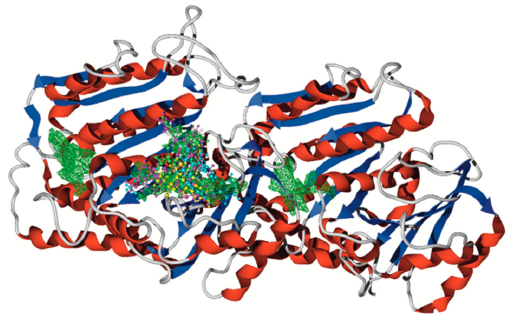
Figure 6. Molecular docking between the three active molecules 1h, k – l (both enantiomers for each one) and the reference drug Paclitaxel, to the αβ -tubulin. Color key: The green surfaces are the cavities one) and the reference drug Paclitaxel, to the α β -tubulin. Color key: The green surfaces are the cavities present in the present in the protein.